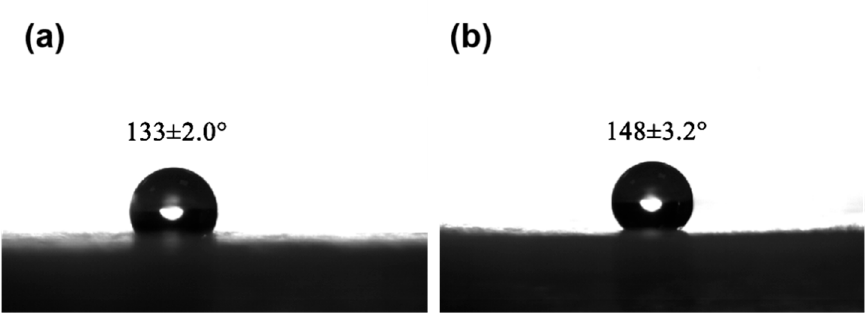
Figure 9. Water contact angle measurement of PLLA fiber membrane: ( a ) before acetone treatment; ( b ) after acetone treatment.